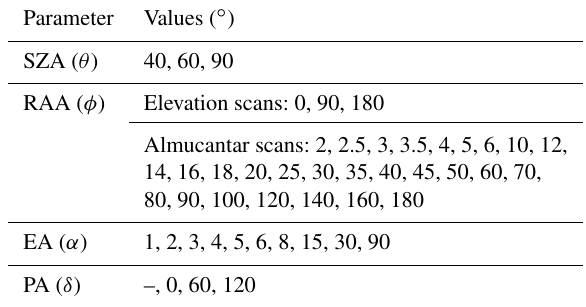
Table 3. Solar and instrument viewing geometries used for the sim- ulation of synthetic observations. Simulations were performed for each combination of EA, SZA, RAA, and PA. A dash in the PA indicates non-polarimetric